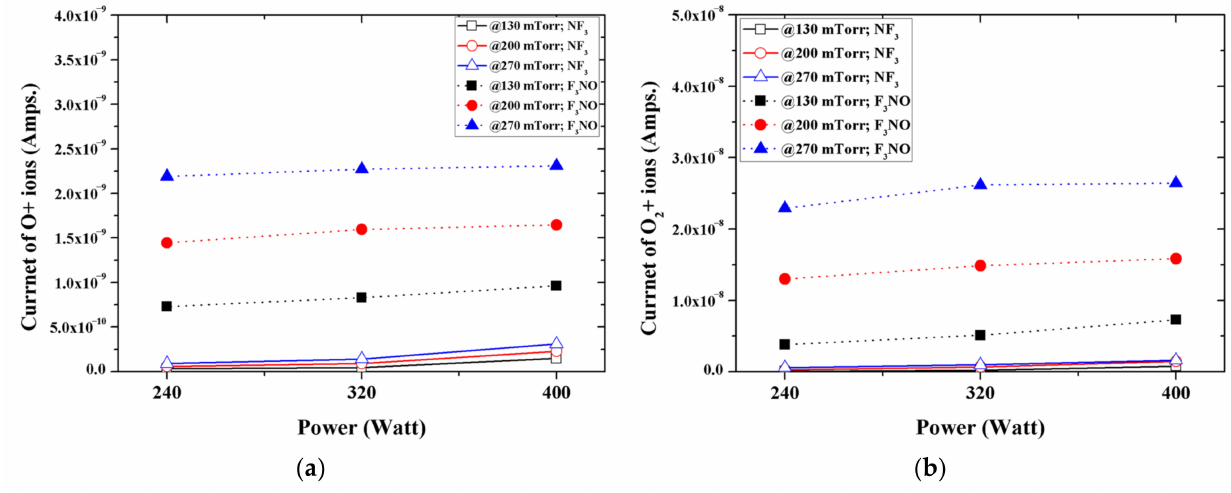
Figure 4. Intensity of: ( a ) O+ ions; ( b ) O 2 + during plasma silicon oxide etching as functions of input power for various working pressures.